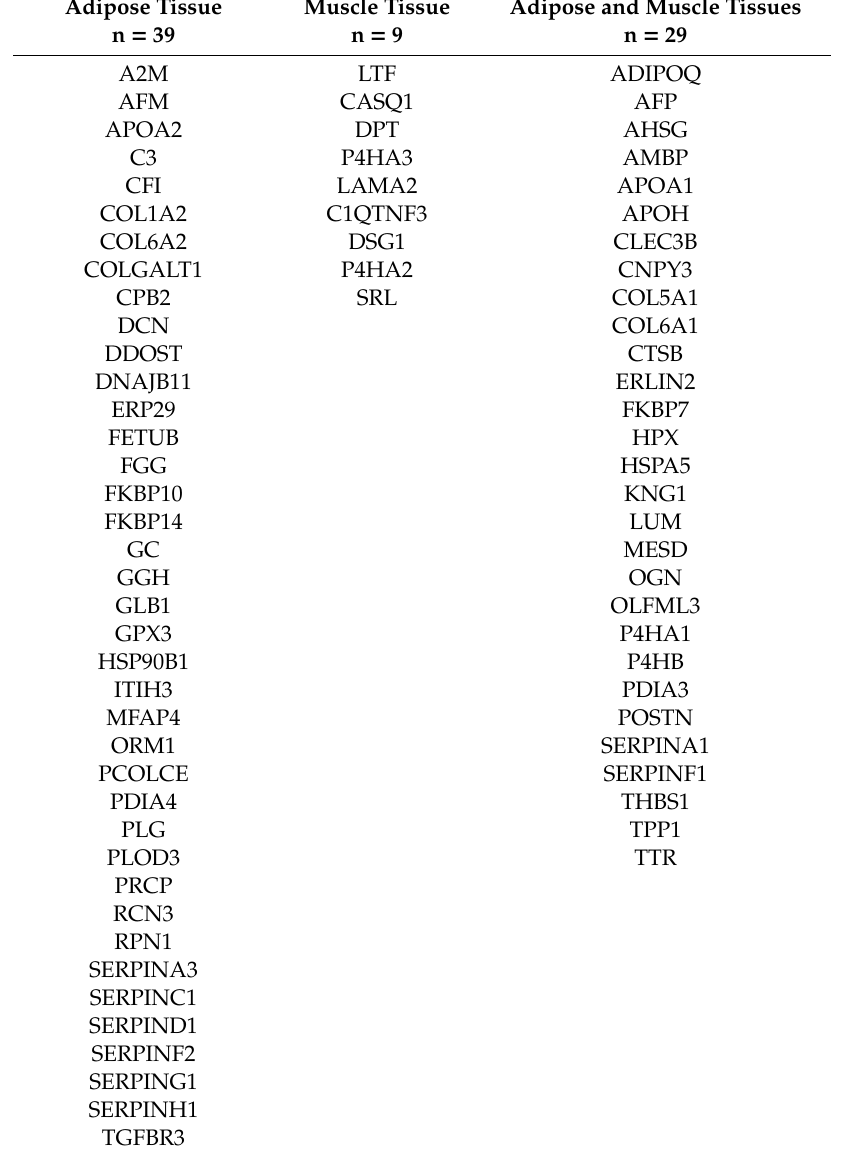
Table1. Proteinspotentiallysecretedthroughasignalpeptidebybovinefetaladiposetissue(AT),muscle, or both tissues. The predictions were performed using the Signal P algorithm and were confirmed by the subcellular location provided by TargetP and Uniprot, thanks to the ProteINSIDE